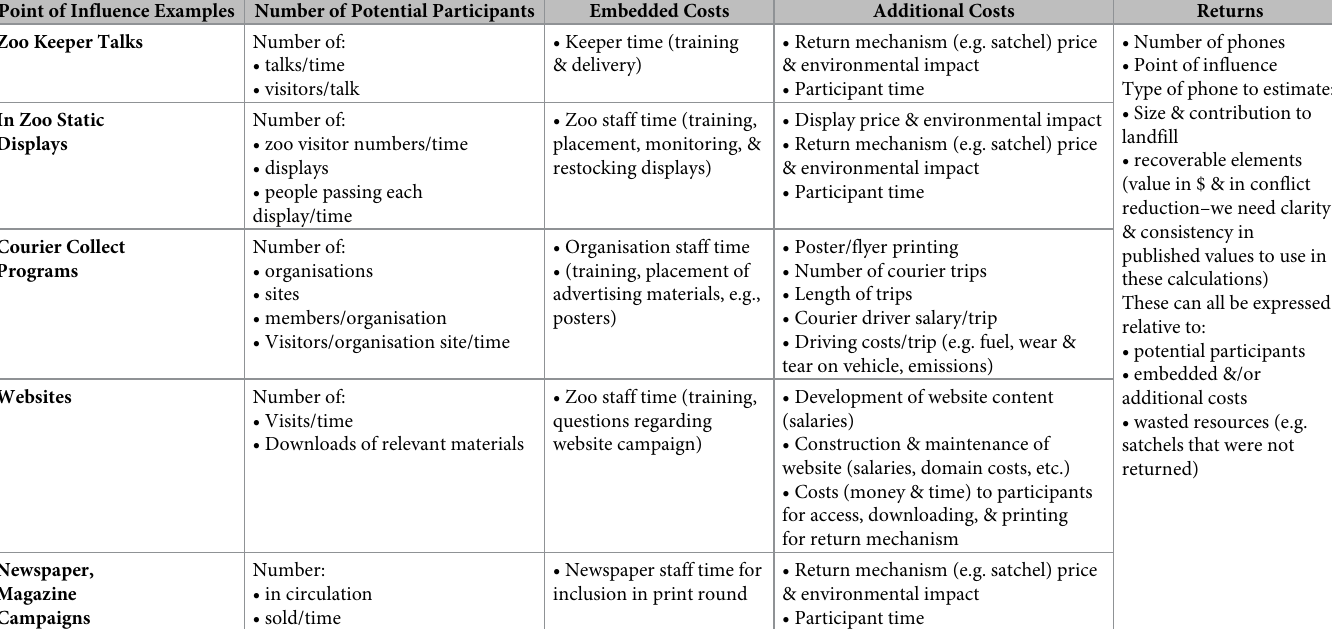
Table 2. For each example point of influence suggestions are given for the information that is needed to evaluate and compare their cost/benefit (non-exhaustive